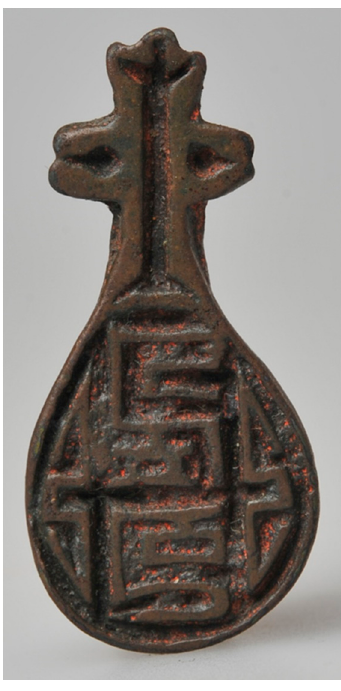
Figure 17. A Song Yuan Huaya in the shape of Hu Pipa with straight neck. The period of the Song and Yuan Dynasties. Inventory number: HKU.m.61.937. Copyright © the database of the University Museum and Art Gallery of the University of Hong Kong.